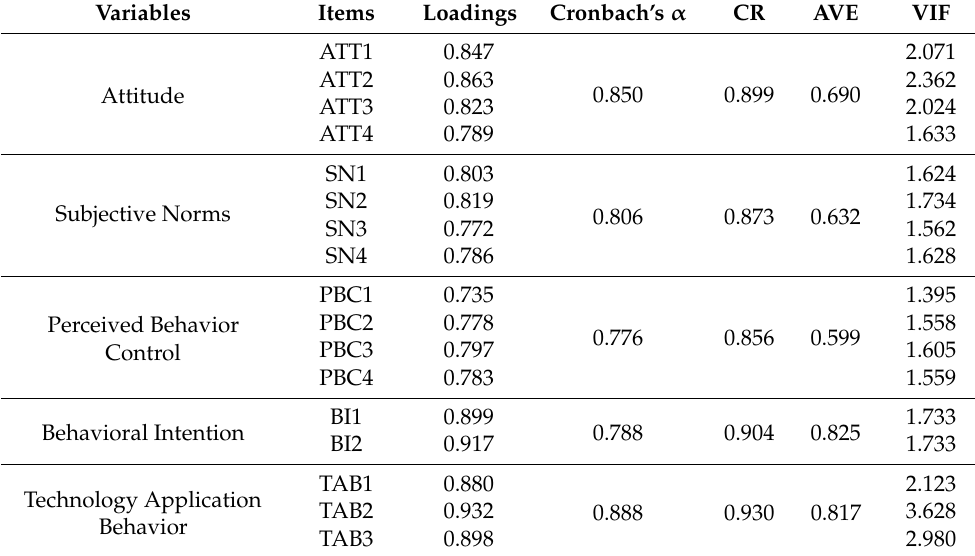
Table 4. Reliability and validity.